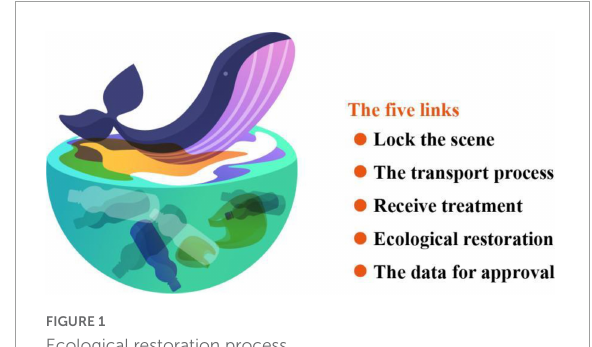
FIGURE1 Ecological restoration